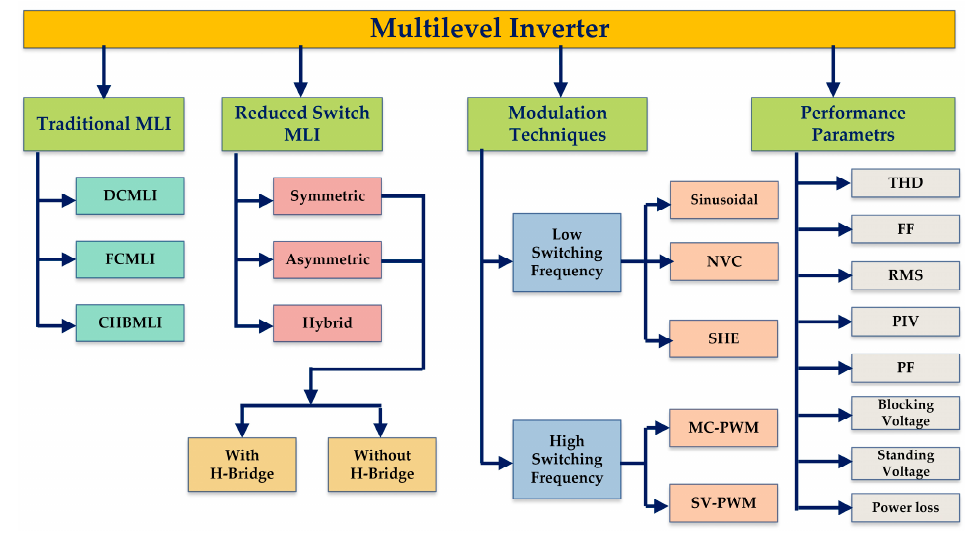
Figure 9. Features of MLIs.